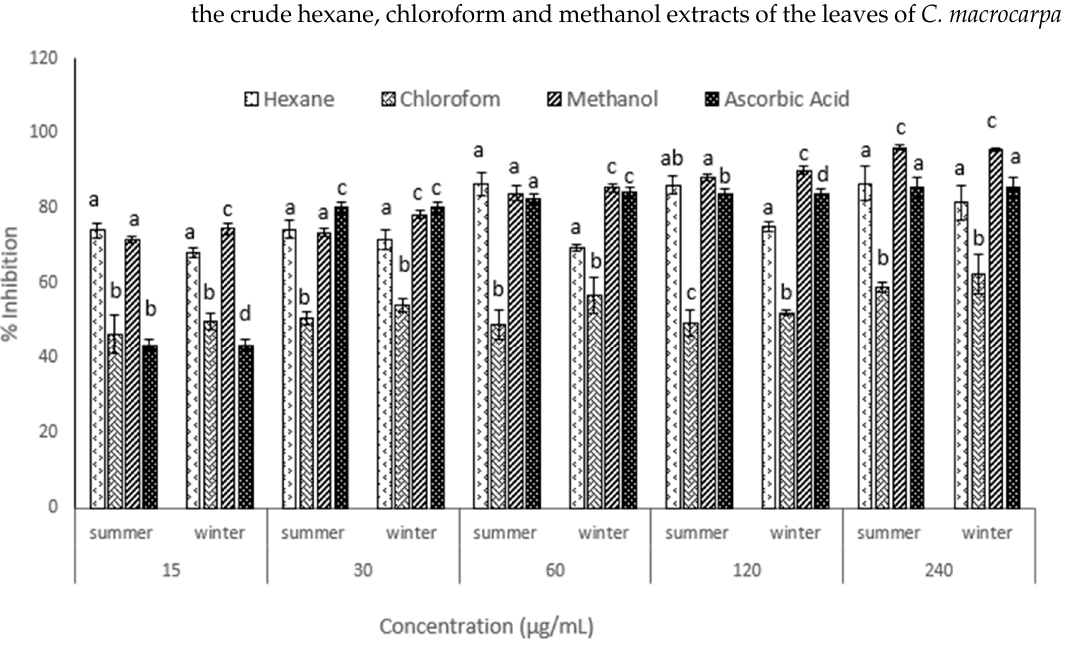
Figure 1. In vitro antioxidant activity (% scavenging) at different concentrations ( µ g/mL) of crude extracts from summer and winter leaves of C. macrocarpa. Different letters means significant at p < 0.05.